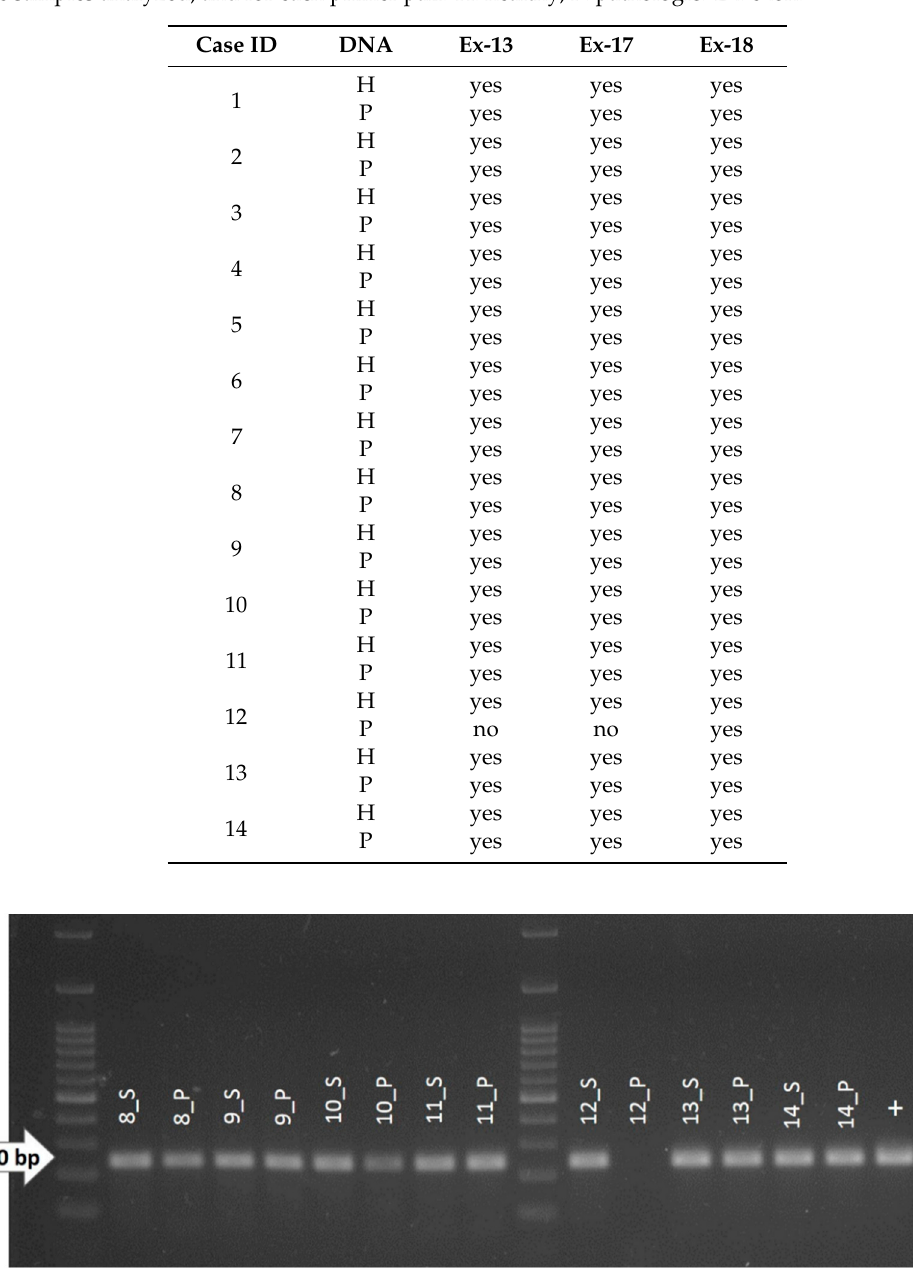
Figure 2. 1.8% agarose gel showing the amplicons obtained by PCR reaction for exon 13 (Ex-13) of the KIT gene. As shown, no amplified DNA was obtained from the pathological fraction of sample 12 (12_P). +: positive control (non-fragmented canine genomic DNA); − : negative control (water).